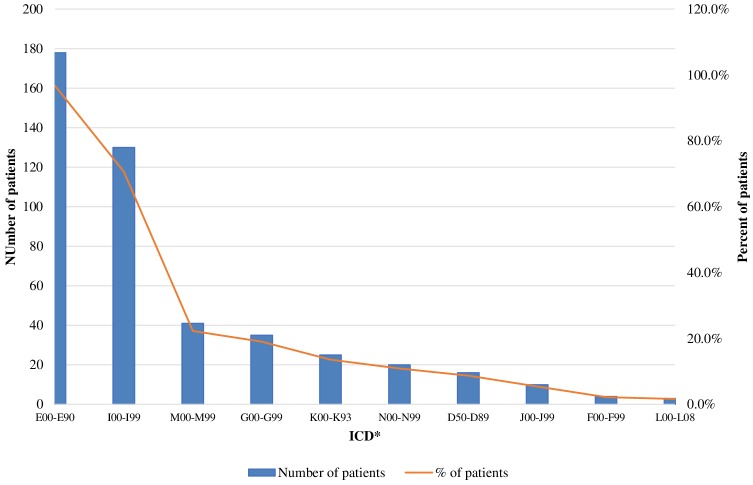
Acromegaly patients with concomitant disease (absolute and relative values). *ICD, International Statistical Classification of disease and related health problems 10th revision (ICD-10); E00-E90, Other endocrine, nutritional and metabolic disease; 100-199, Disease of the circulatory system; M00-M99, Disease of the musculoskeletetal system and connective tissue; G00-G99, Disease of the nervous system; K00-K93, Disease of the digestive system; N00-N99, Disease of the genitourinary system; D50-D58, Disease of the blood and blood-forming organs and certain disorders involving the immune mechanism; J00-J99, Disease of the respiratory system; F00-F99, Mental and behavioral disorders; L00-L08, Disease of the skin and subcutaneous tissue.